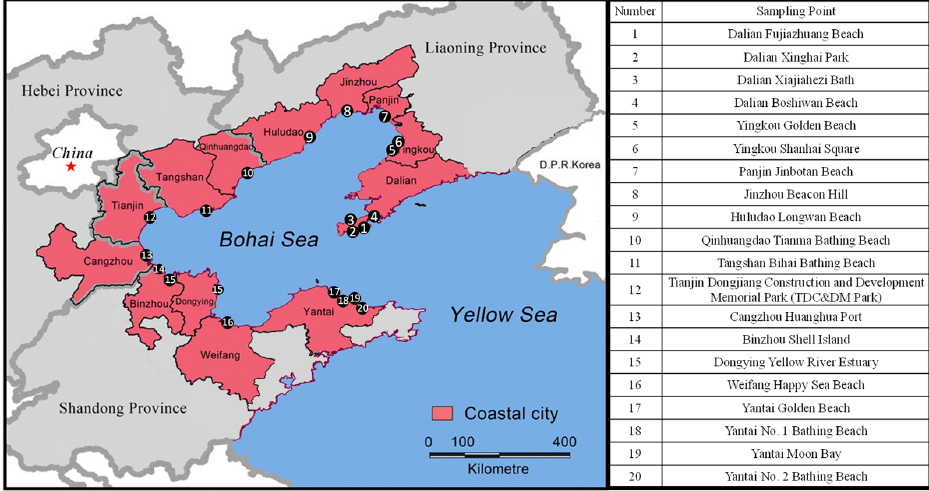
Figure 1. Study area and beach waste sampling points around the Bohai Sureea region.